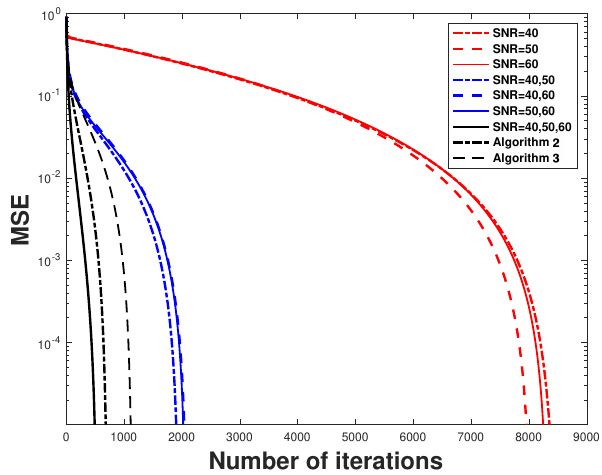
Figure 6. Recovered signal by Algorithms 2, 3 and 6 inputting A 1 , A 2 and A 3 , respectively.